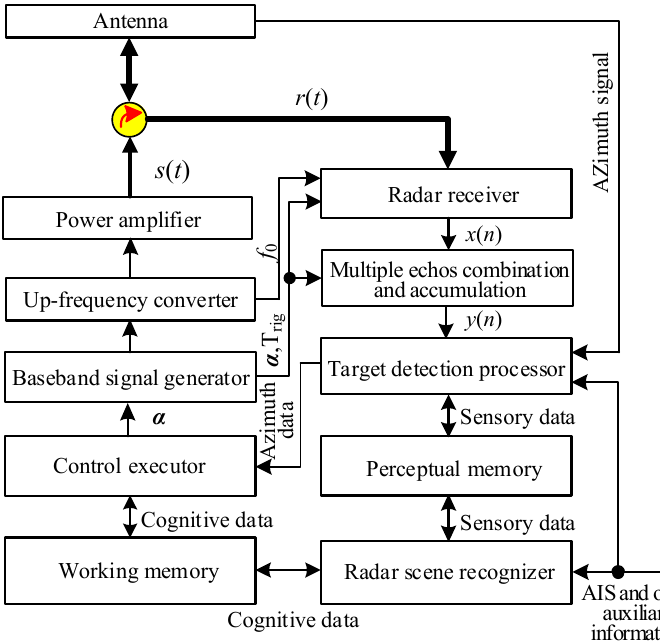
Figure 4. Structure block diagram of cognitive marine radar.